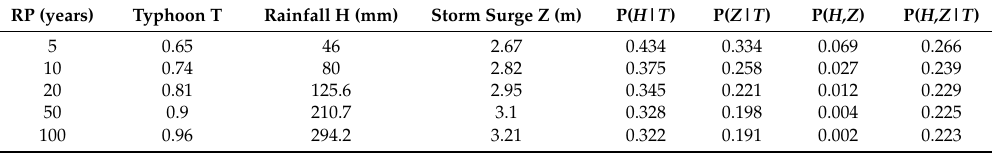
Table 9. Probabilities P ( H > h | T > t ) , P ( Z > z | T > t ) , P ( H > h , Z > z ) , and P ( H > h , Z > z | T > t )